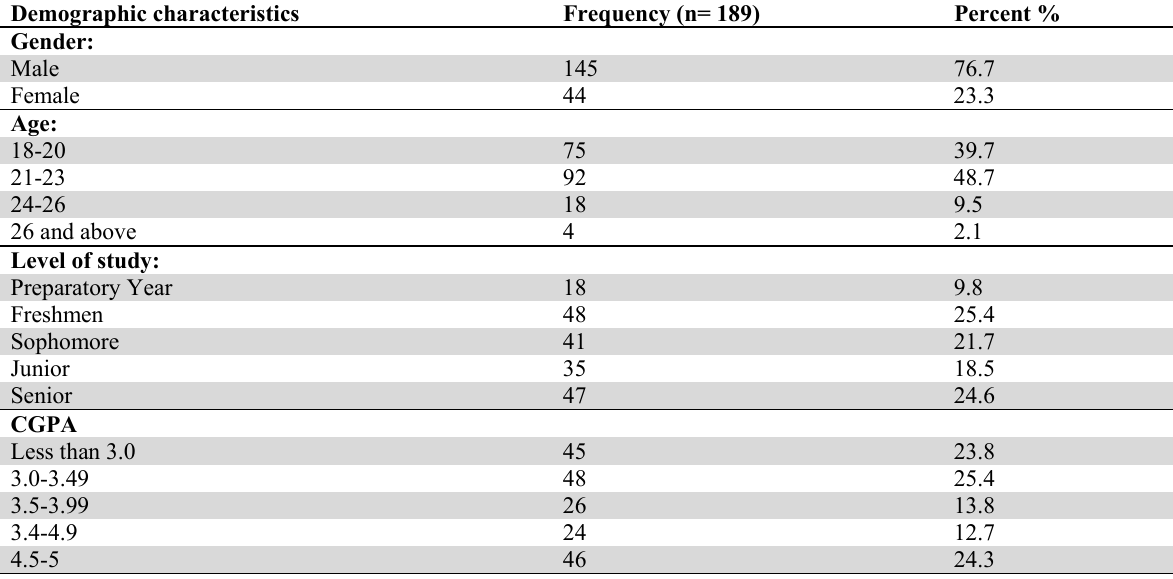
Demographic characteristics